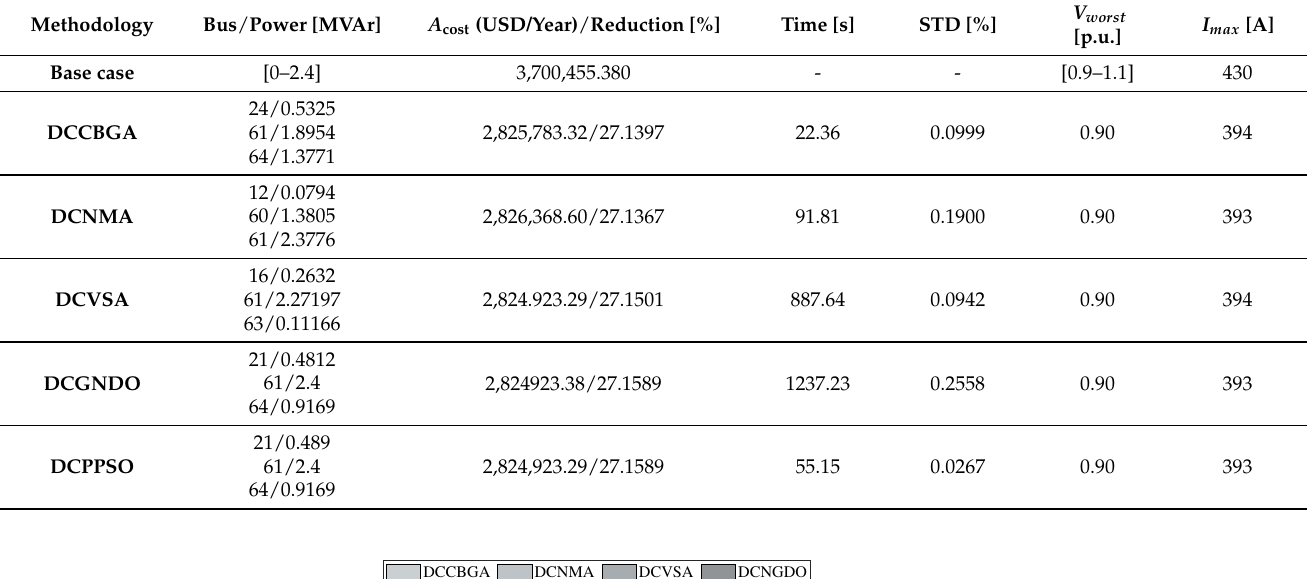
Table 5. Simulation results obtained by the solution methodologies in the 69-bus test system (AC and DC networks).